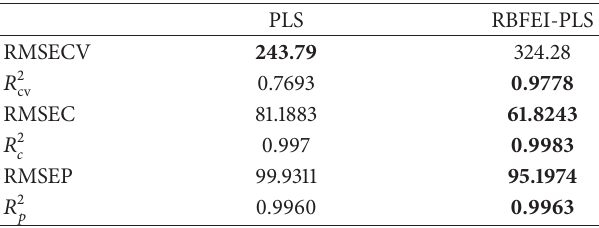
Table 2: Experiment results for CO.